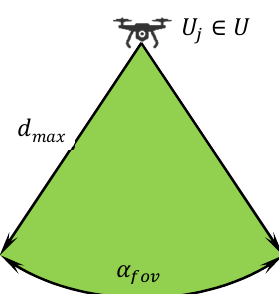
Figure 1. Object detection range of a sensor of an Unmanned Aerial Vehicles (UAV).